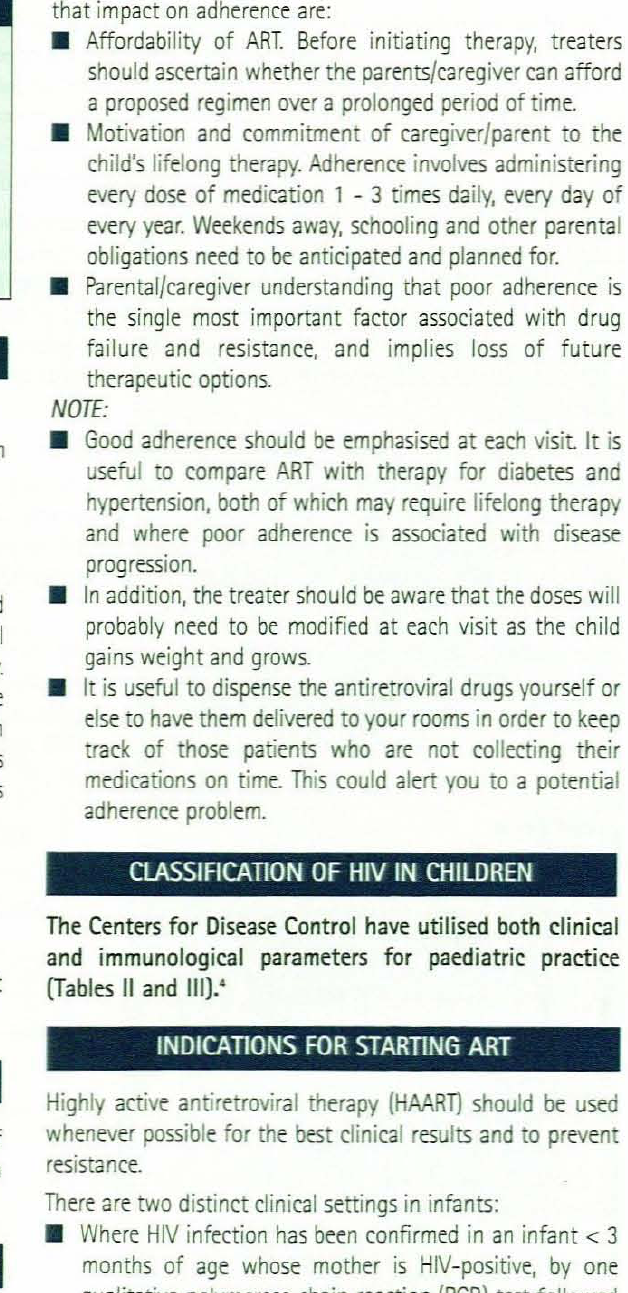
TABLE I. BASEUNE C04+0f0 AND HIV COPY NUMBER: RISK OF DEATH HIV RNA Baseline Patients